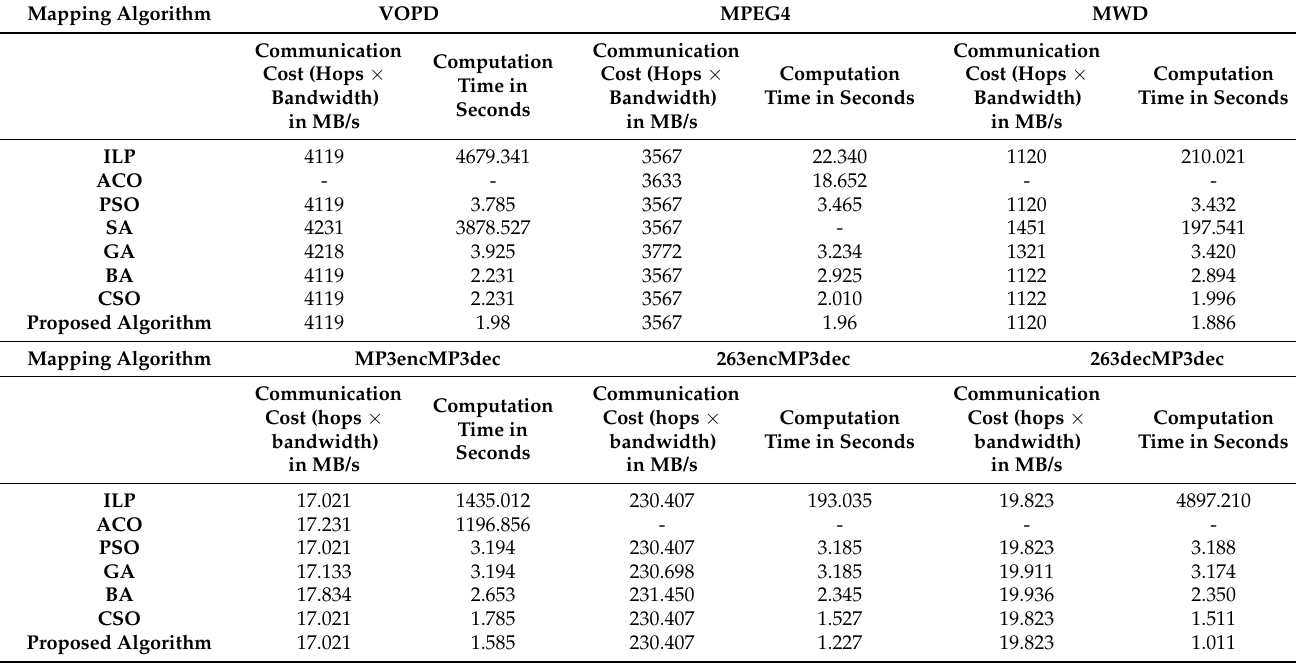
Table 6. Communication cost and computation time of 2D NoC 4 × 4 mesh for standard NoC benchmarks. Mapping Algorithm